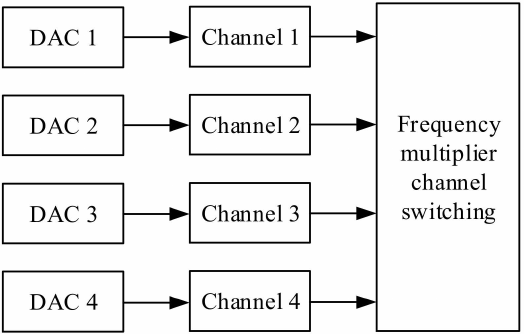
Figure 4. Signal generation circuit structure model based on TIDAC.